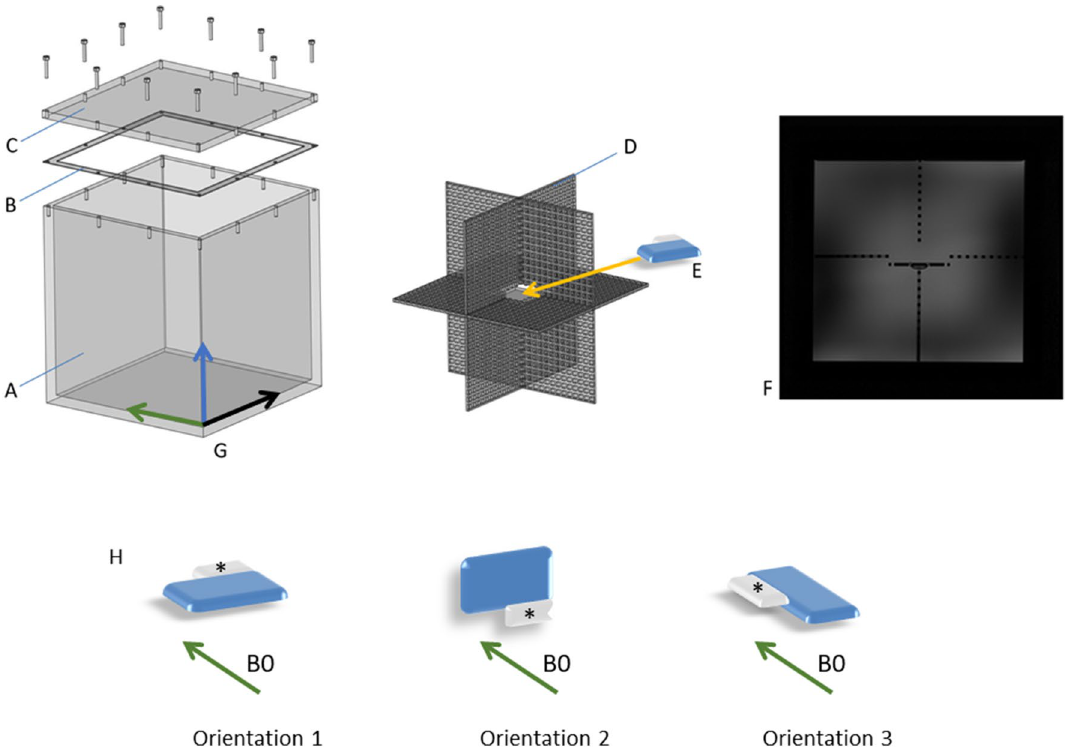
Figure 1. The phantom consists of an acrylic canister A, closed by the lid C. The seal B ensures a water-tight closure of the phantom and prevents spills of the filling during positioning. D shows the acrylic implant holder. The implant E fits into the central space of the implant holder. F shows a scan through the phantom, showing a central section of the implant holder. The implant holder F allows three different orientations of the device relative to the B0 field (H). Changes in the orientation were achieved by turning the implant holder within the phantom. The coordinate system (G) on the phantom guided the repositioning (green arrow: Z- axis, following the direction of the B0 field, X- and Y- axis (black and blue arrows), perpendicular to the Z- axis). The asterisks mark the device header. The blue part is the implant’s main body. Orientation 1 was defined by X: left–right, Y: foot-head, Z: bottom-up. Orientation 2 was defined by X: left–right, Y: top-down, Z: foot-head. Orientation 3 was defined by X: foot-head, Y: right-left, Z: